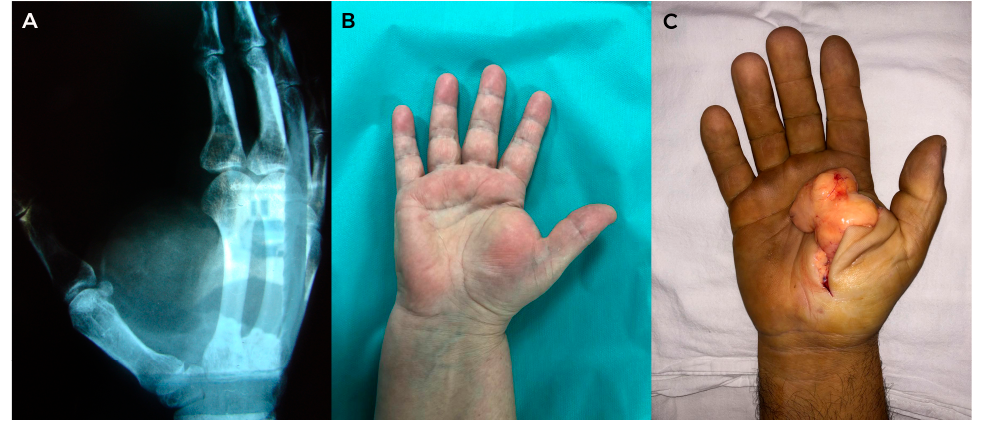
Figure 9. Lipoma ( A ) radiological appearance of hand lipoma—homogeneous soft tissue lucency between the 1st and 2nd metacarpal bones; ( B ) thenar lipoma—preoperative view; ( C ) thenar lipoma—intraoperative view .